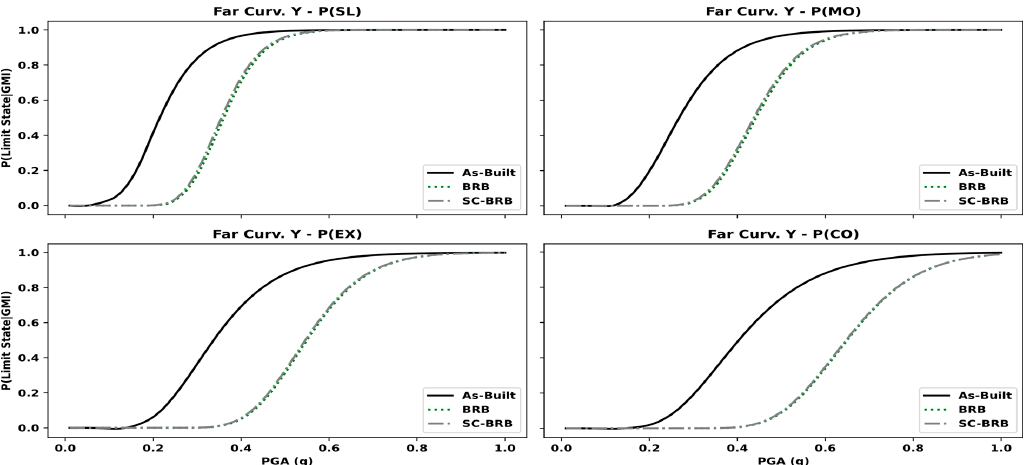
Figure 25. Fragility curves of bridge bent CD demands under far-field records in the transverse direction (as-built vs. retrofitted bridges with different BRB techniques).